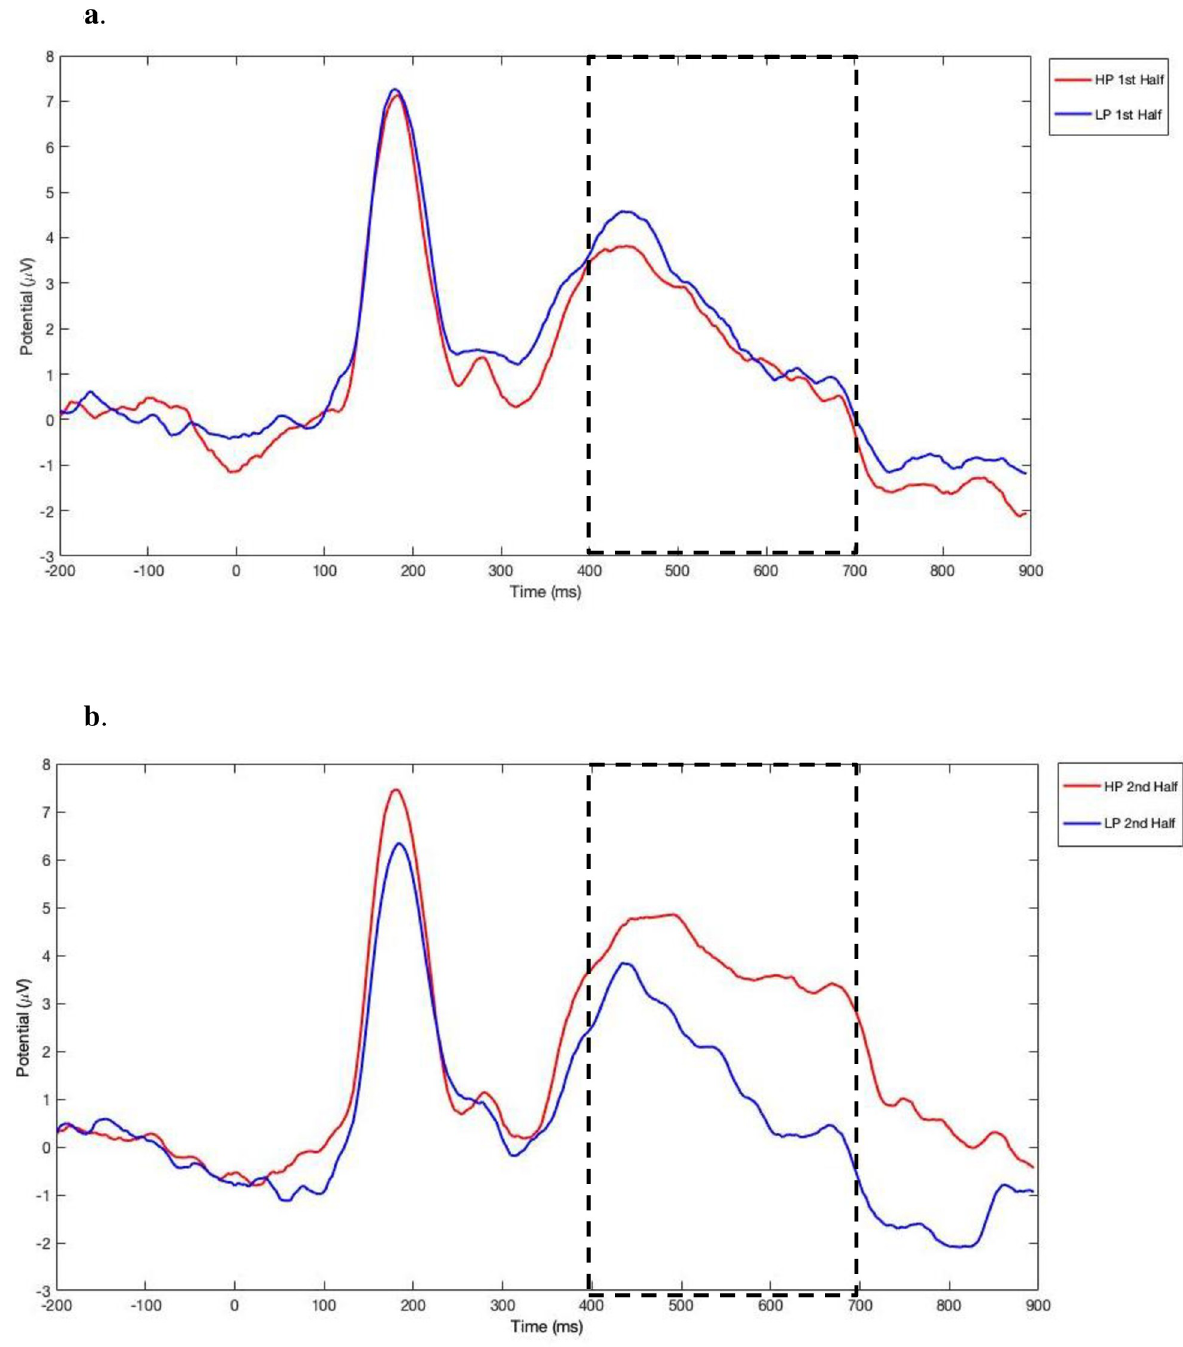
Fig 4. ERP average waveforms in the posterior region elicited during the statistical learning task. (a) average waveforms in the first half of the task. (b) average waveforms in the second half of the task. High-probability: red; low-probability: